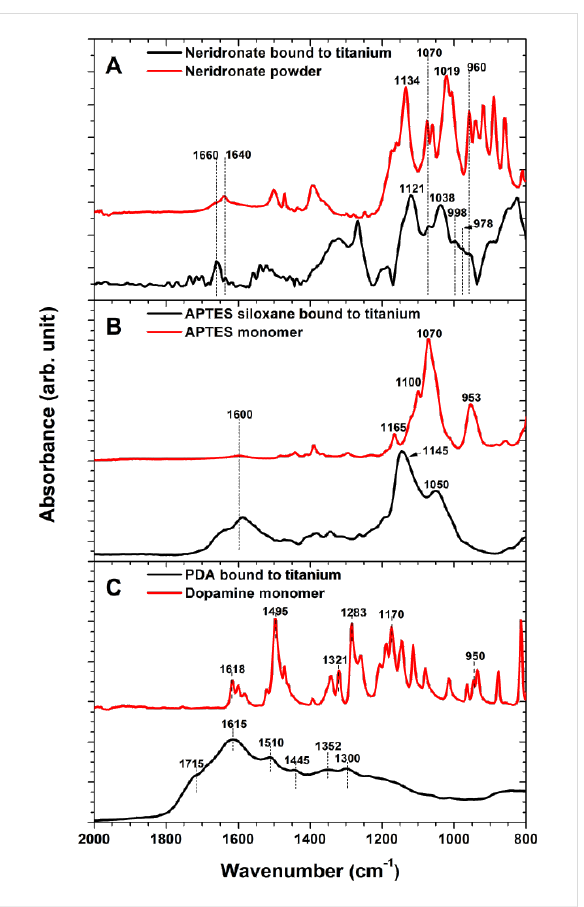
Figure 2: FTIR spectra of starting neridronate (A), APTES (B) and do- pamine (C) organic moieties in their native state (red) and corres- ponding immobilized films on activated flat titanium surfaces (black). The spectra of the immobilized films were taken in IRRAS mode against backgrounds of bare